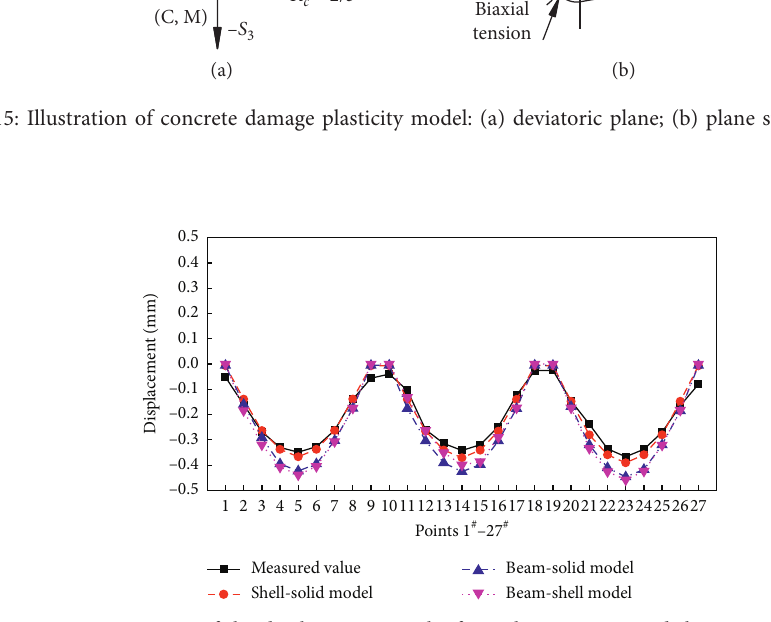
Figure 16: Comparison of the displacement results from the static test and the FE model